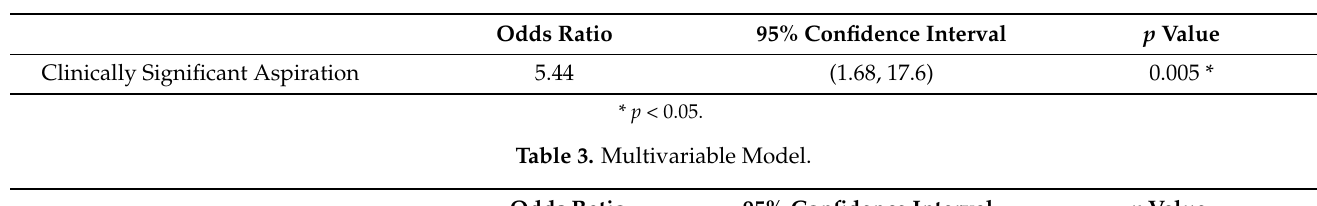
Table 2. Unadjusted Model.